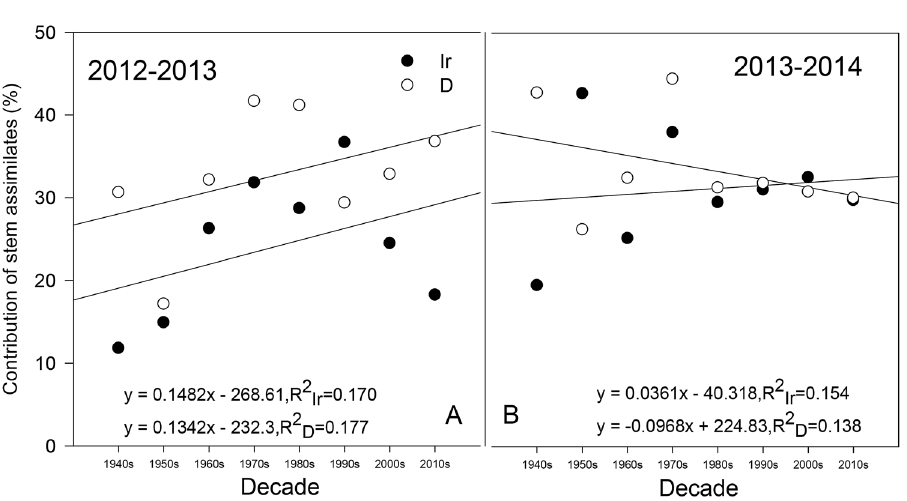
Figure 8. Contribution of preanthesis stem assimilates (CSA) to grain weight in different cultivars. *Significant at P < 0.05; ** significant at P < 0.01; Ir indicates the irrigation treatment; D indicates the drought